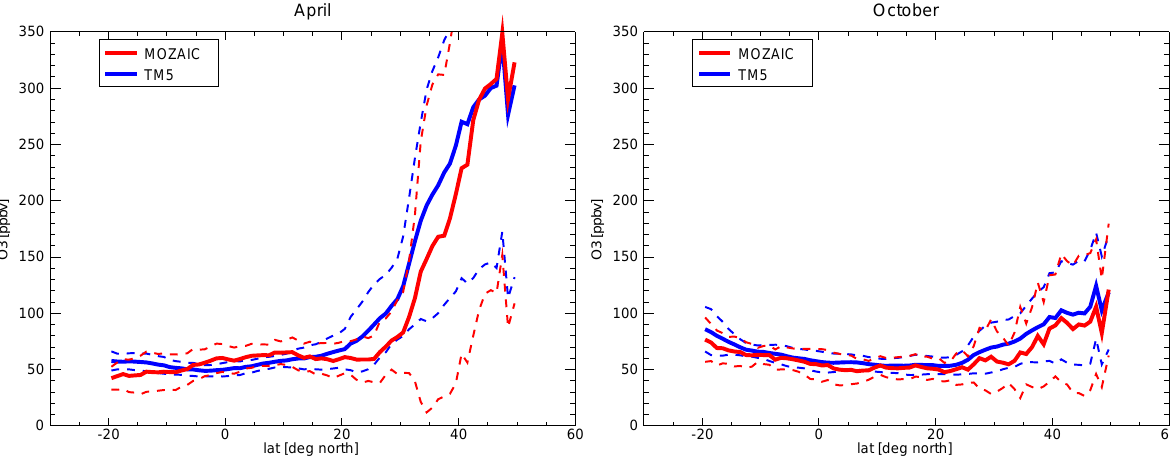
Fig. 17. Comparison of monthly average MOZAIC flight data for O 3 , as in Fig. 6.